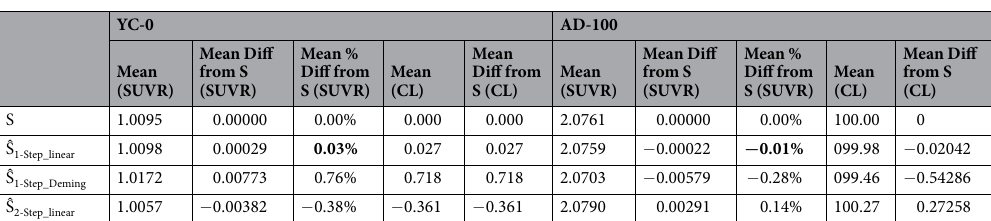
Table 3. Comparisons between S and calculated S (Ŝ) for each group (YC-0: young controls, the zero-point of the Centiloid scale; and AD-100: subjects with Alzheimer’s disease, the 100-point of the scale), using each of the variations of Ŝ (defined in Table 2). The variation with the smallest deviation from S is marked in